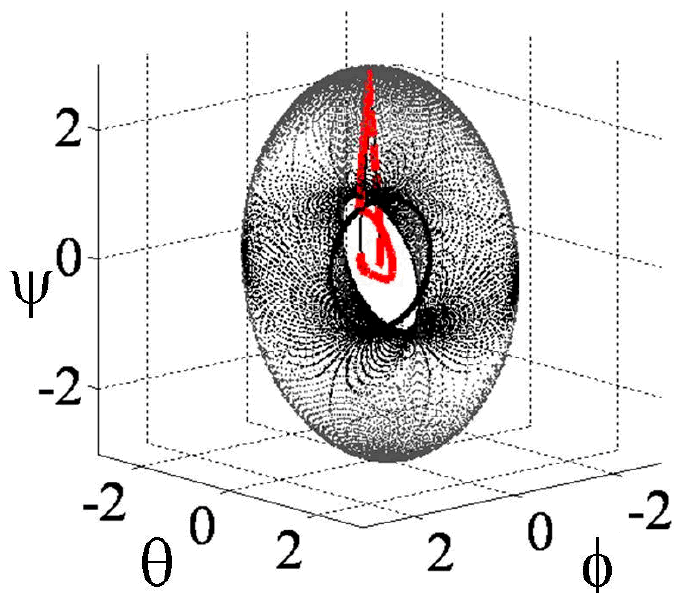
Figure 5. SIMULATION: Direct comparison of coupled versus decoupled control methods.